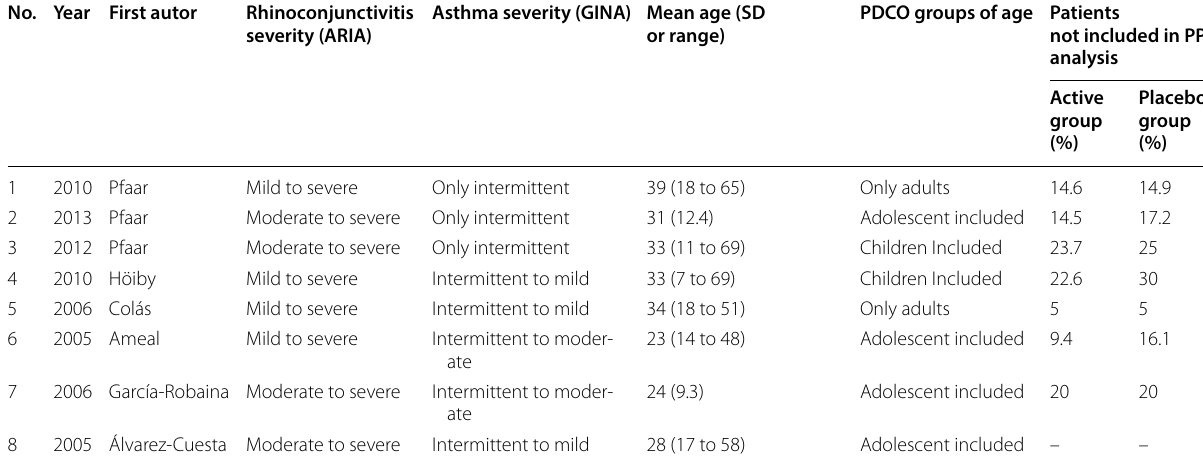
Table 3 Main clinical characteristics of included articles